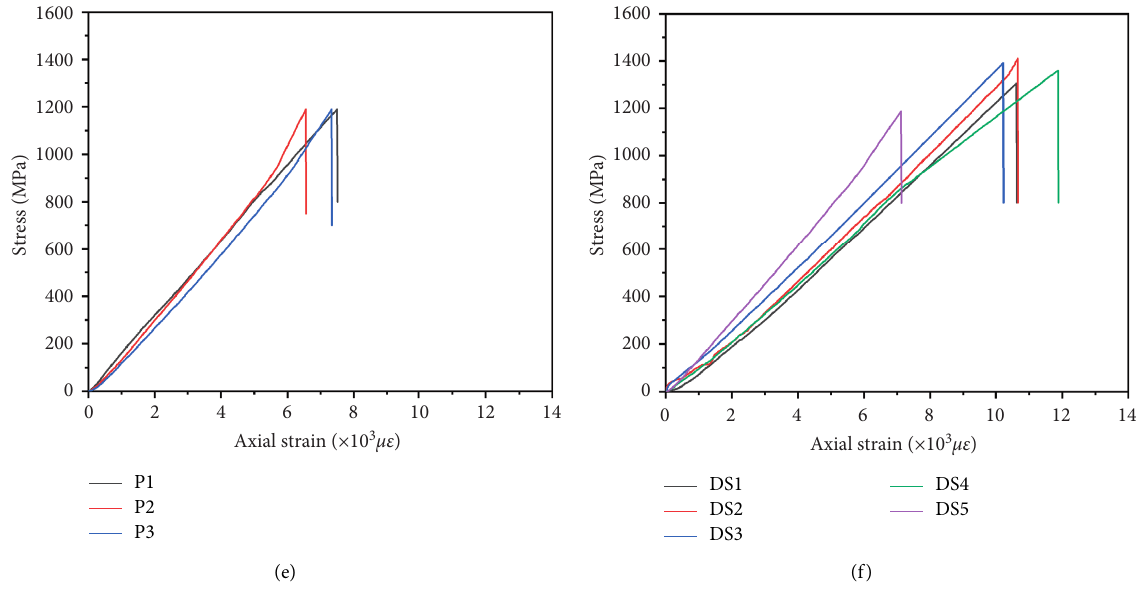
Figure 15: Stress-strain curves of CFRP rod anchored by dissolution-rebond anchor. (a) DS1. (b) DS2. (c) DS3. (d) DS4. (e) DS5. (f) Average. Table 2: Ultimate tensile forces and stresses of CFRP rods anchored by dissolution-rebond anchors. Specimen